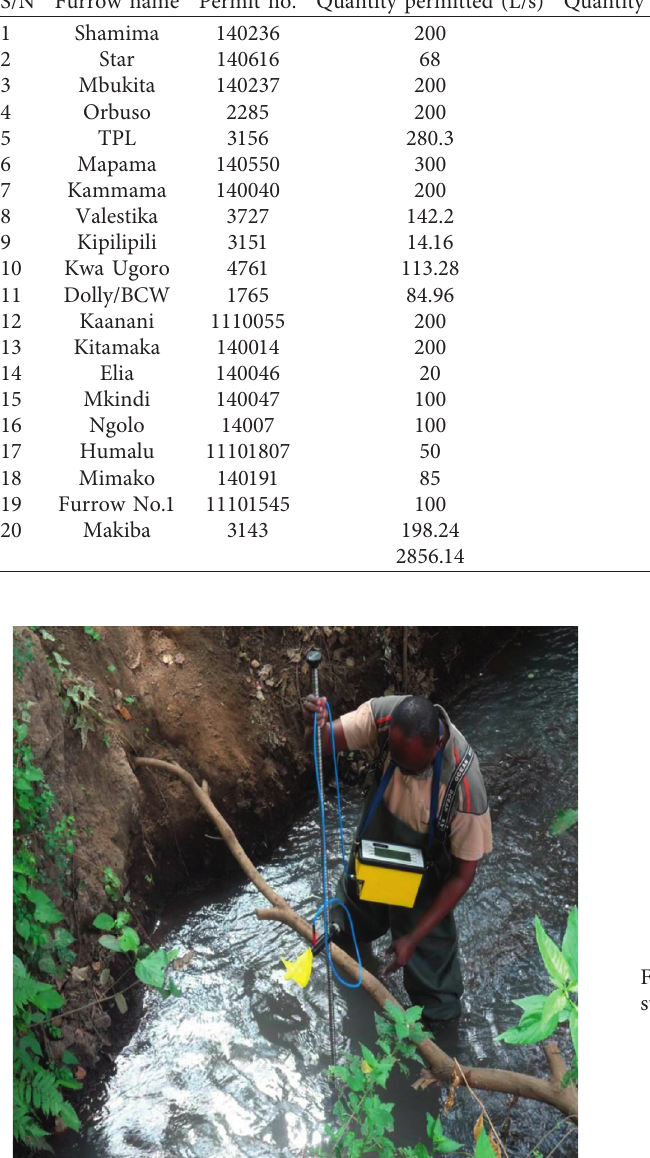
Figure 3: Water flow measurement at traditional canal using current meter.